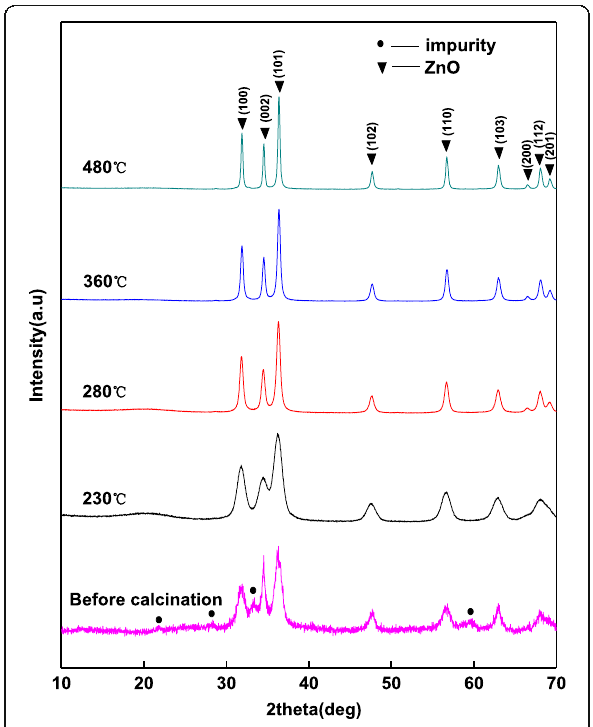
Fig. 1 XRD patterns of the zinc oxide powders calcined at different